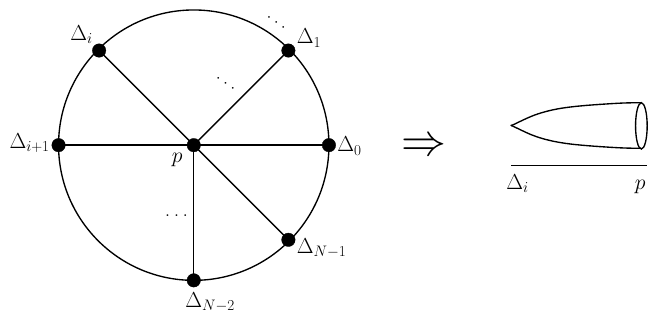
Figure 2. We choose a junction basis as straight line paths from p to the vanishing loci (cid:1) i . As illustrated on the right hand side, a cycle vanishes as one starts from p and approaches (cid:1) i